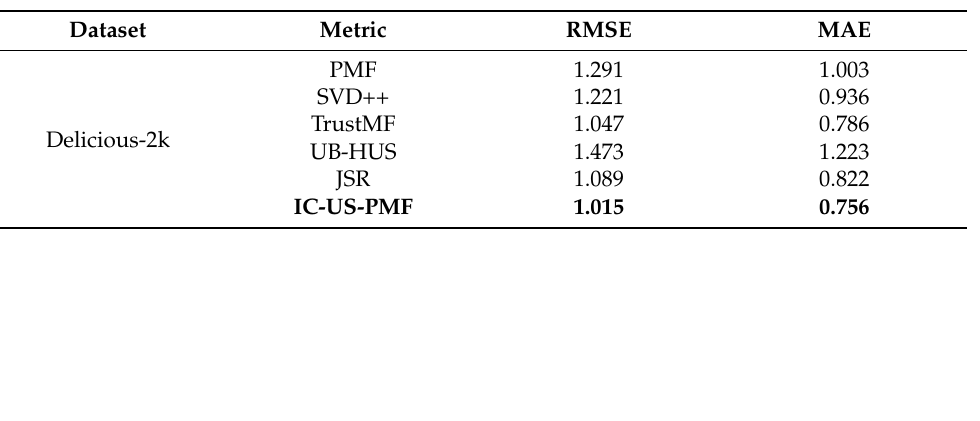
Table 6. Comparison of recommendation performance of each algorithm on all user